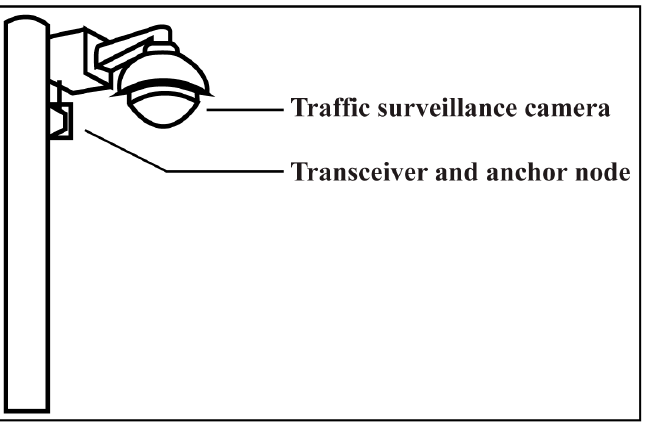
Figure 1. Tra ffi c surveillance road camera as an external image source and anchor node for exact detection and AI networking system. detection and AI networking